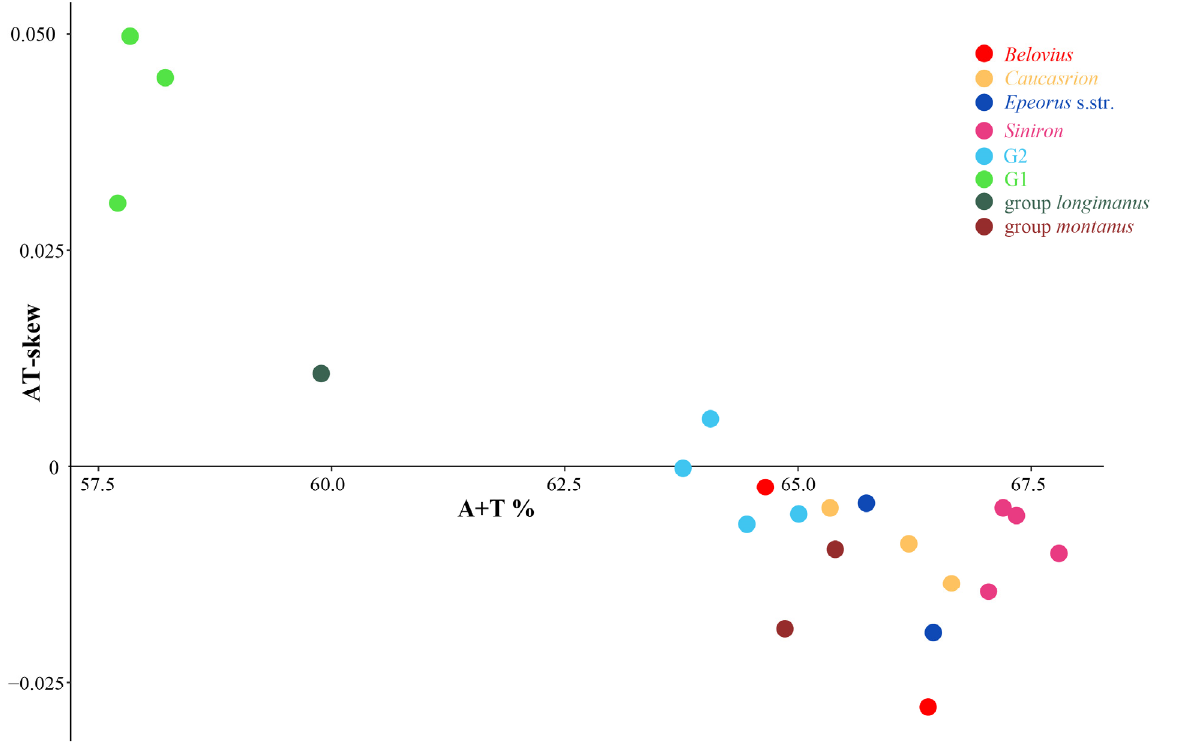
Figure 2. Scatterplots of A + T content and value of AT-skew for whole mitogenomes of Epeorus